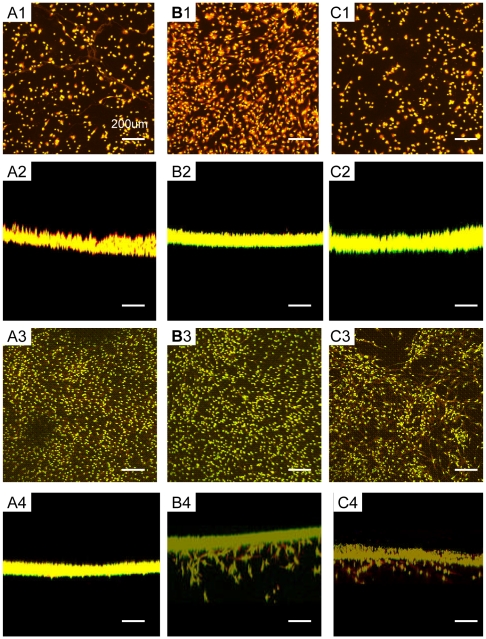
Constructed images of 3-D confocal microscopy images of periodontal ligament fibroblasts on the different scaffolds.Fluorescent staining with Rhodamin phalloidin and SYTOX Green. A) RADA16, B) PRG and C) PDS. A1, B1,C1) Vertical and A2, B2,C2) horizontal images after five hours culture. A3, B3, C3) Vertical and A4, B4, C4) horizontal images after two weeks culture. There were significant cell migrations into the functionalized peptide scaffolds PRG and PDS after two weeks. The scale bar represents 200 um for all images.